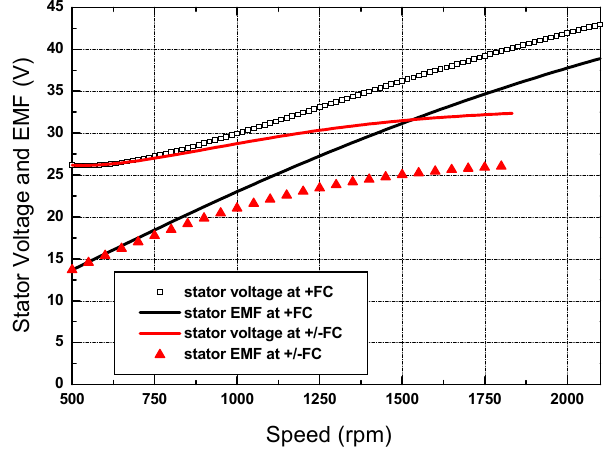
Figure 8. Output, input power, and torque at reduced and reversed FC.